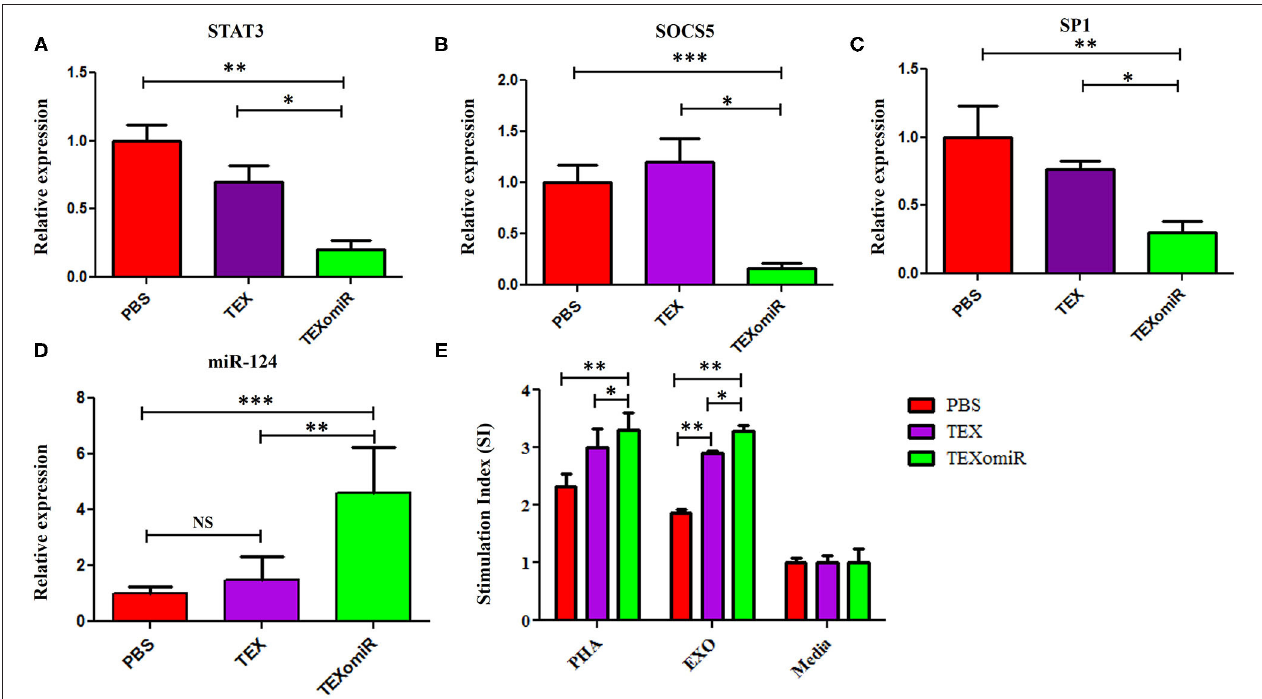
FIGURE 11 | The effect of TEXomiR on miR-124 target genes and lymphocyte proliferation in splenocytes from CT-26 tumor-bearing mice. (A) qRT-PCR analysis represented a significant reduction of STAT3 expression in the TEXomiR group compared to the TEX and phosphate-buffered saline (PBS) groups. (B) Relative expression of SOCS5 in the TEXomiR, TEX, and PBS groups. (C) Relative expression of SP1 in the TEXomiR, TEX, and phosphate-buffered saline (PBS) groups. (D) Relative expression of miR-124 in splenocytes of TEXomiR, TEX, and PBS-treated mice. (E) MTT test for evaluation of the stimulation index of lymphocytes in the spleen. The data are presented as mean ± SD. * P < 0.05, ** P < 0.01, *** P < 0.001. One-way ANOVA was used to make comparisons between groups. TEXomiR, miR-124-3p-enriched TEXs; TEX, tumor